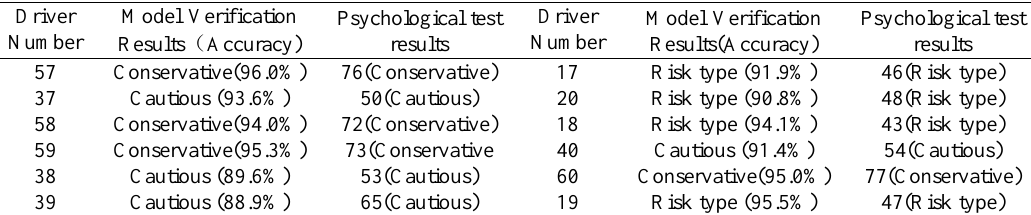
Table 10. Verification